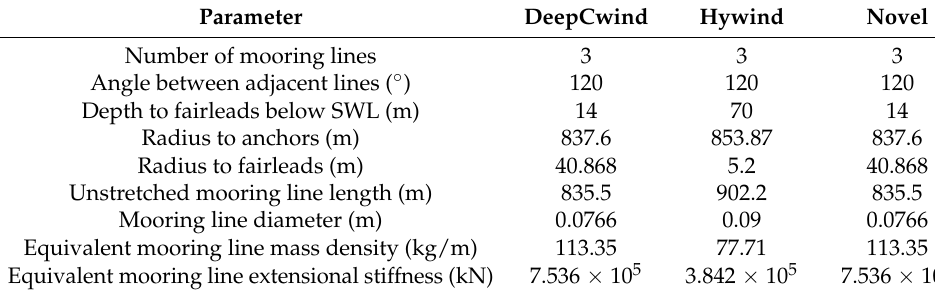
Table 8. Mooring system properties of three